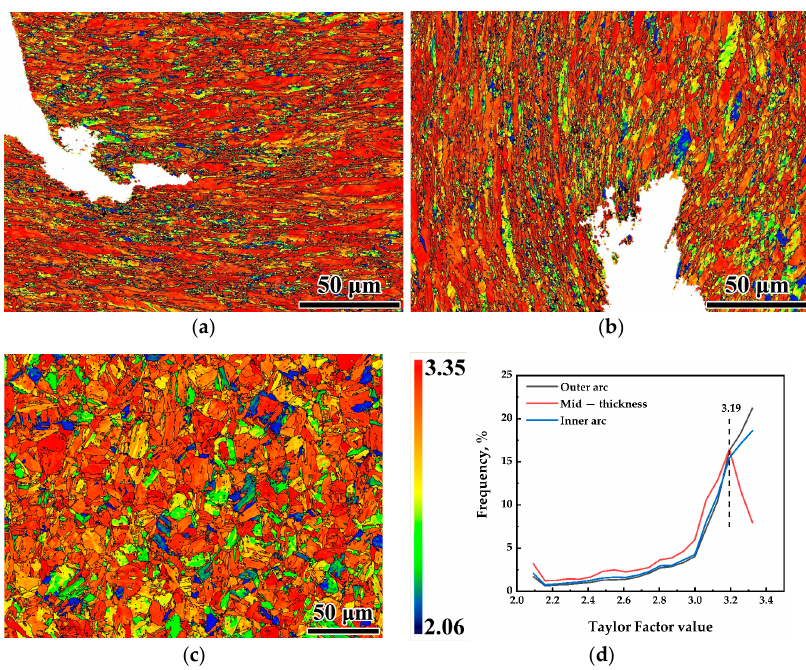
ability of the steel. When TF is more than 3, the grains are called “hard” grains, which are